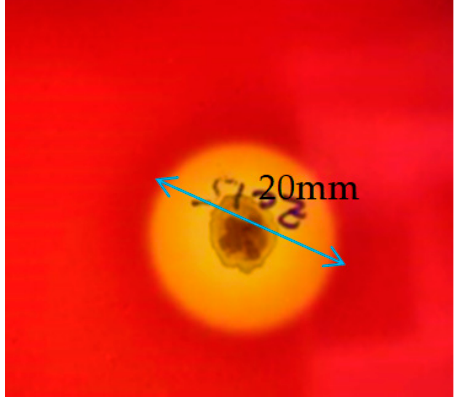
Figure 2. Hemolysis test results confirmed the presence of biosurfactants of the glycolipid family, as shown by the clear zone around the bacteria colony of Pantoea alhagi strain Zcb15.